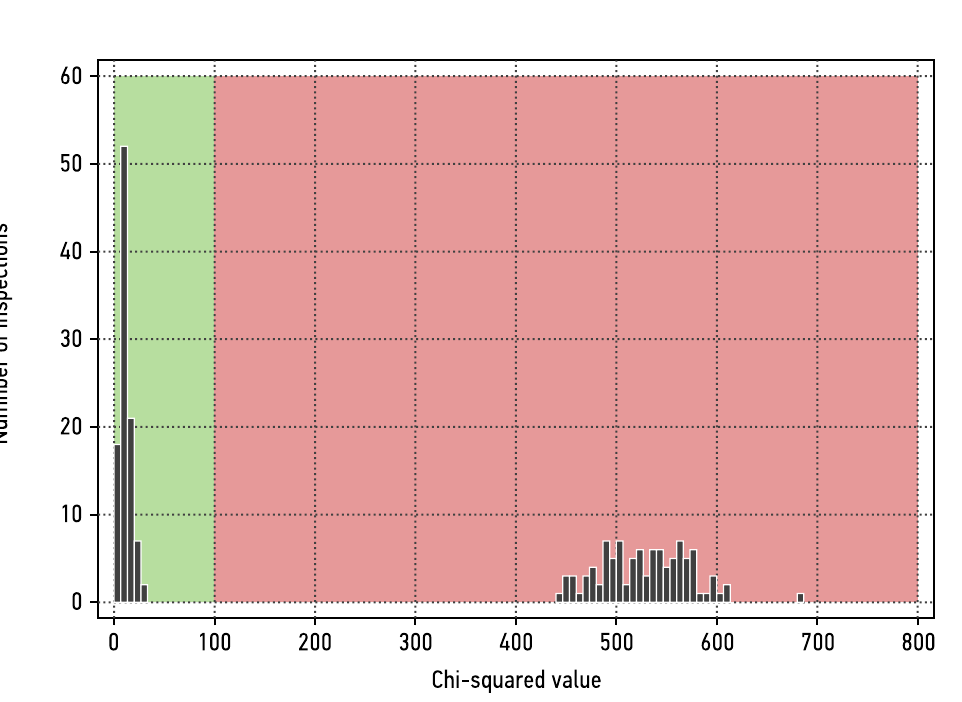
Fig 6. χ 2 -result for 150 measurements each on the valid and on the invalid item, compared to the template. χ 2 values for valid and invalid items are clearly distinct. The pass/fail threshold value, here arbitrarily set at w 2 requirements for false-positive and false-negative rates.